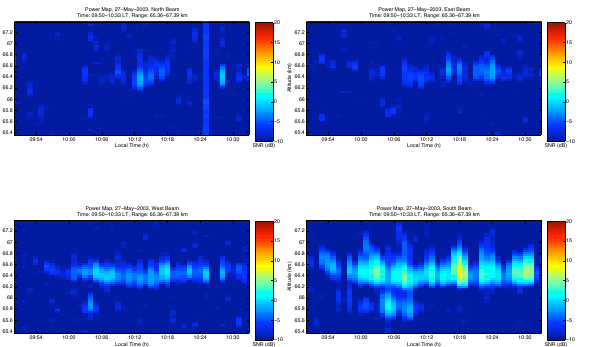
Fig. 18. SNR map in all four beams of event at 66.5 km on May 27, 2003 at 10:00 LT.